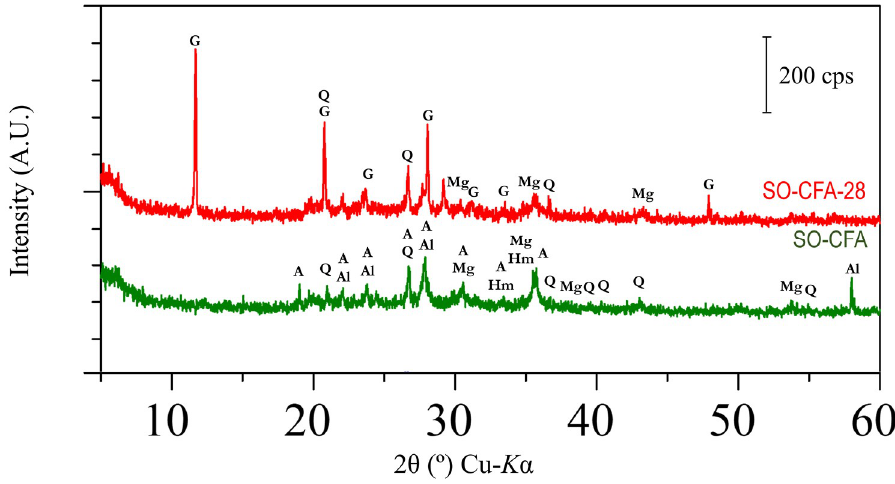
Figure 6. XRD comparative analysis of SO-CFA and SO-CFA-28 (Q—Quartz; Hm—Hematite; Mg—Magnetite; G—Gypsum; A—Anorthite; Al—Albite).